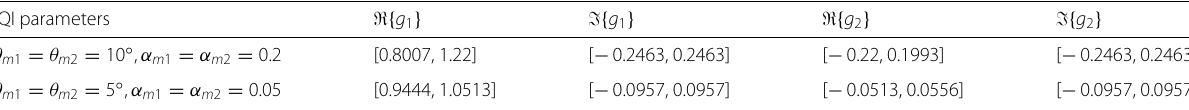
Table 1 The ranges of (cid:3){ g 1 } , (cid:4){ g 1 } , (cid:3){ g 2 } , and (cid:4){ g 2 } IQI